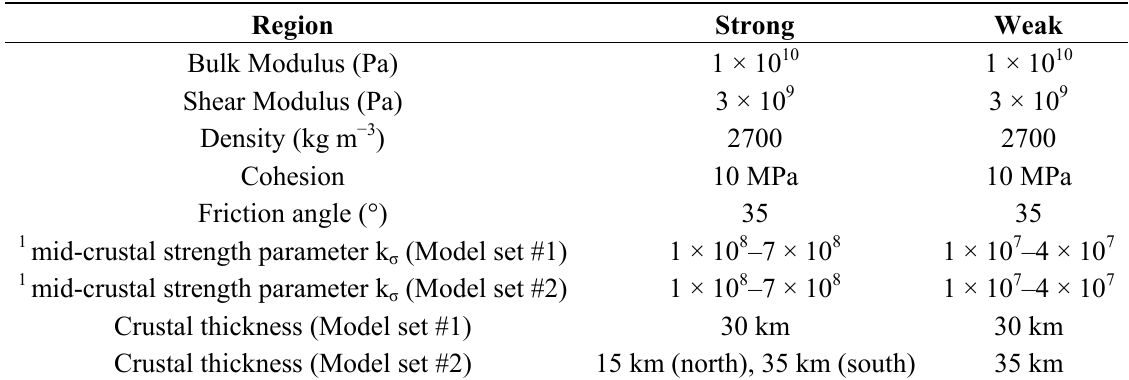
Table 1. Rheological parameters used in the